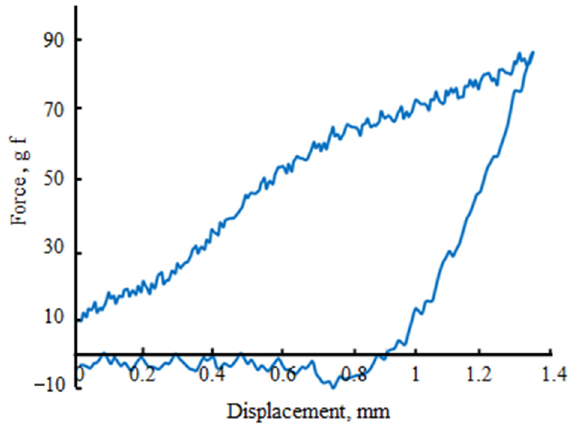
Figure 13. The relationship between force and displacement of the probe.